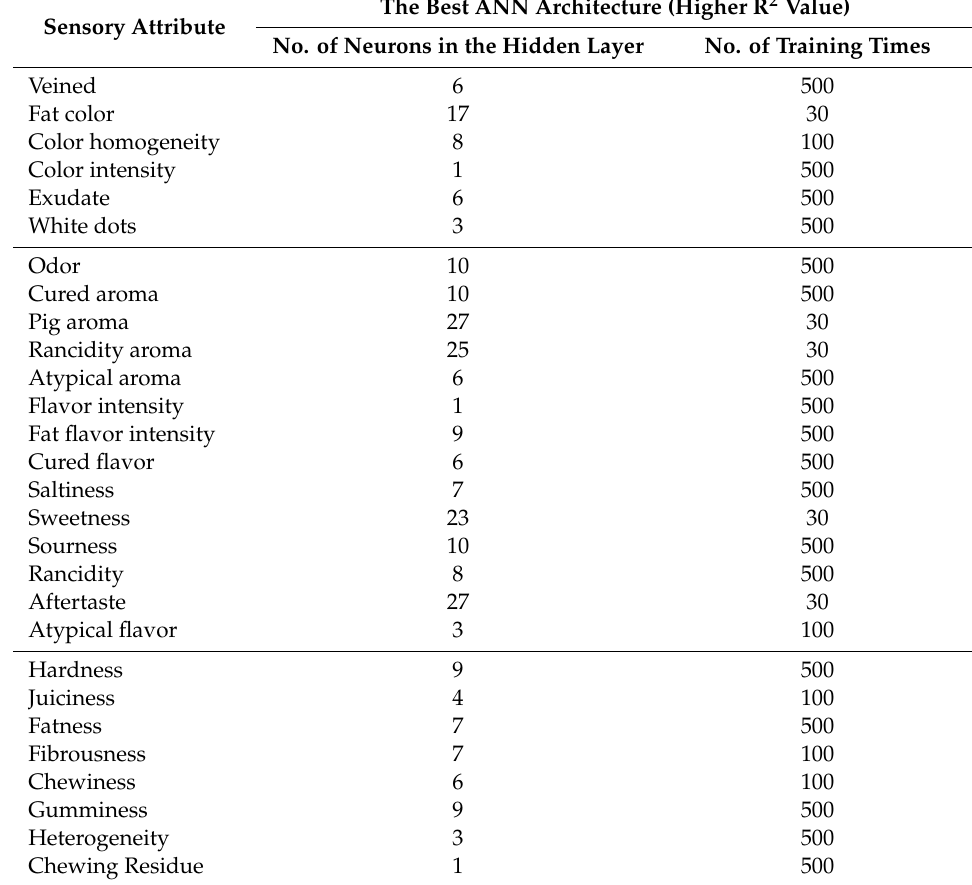
Table 4. ANN architecture (training times and the number of neurons in the hidden layer) for each of the sensory parameters analyzed. The Best ANN Architecture (Higher R 2 Value) Sensory Attribute No. of Neurons in the Hidden Layer No. of Training